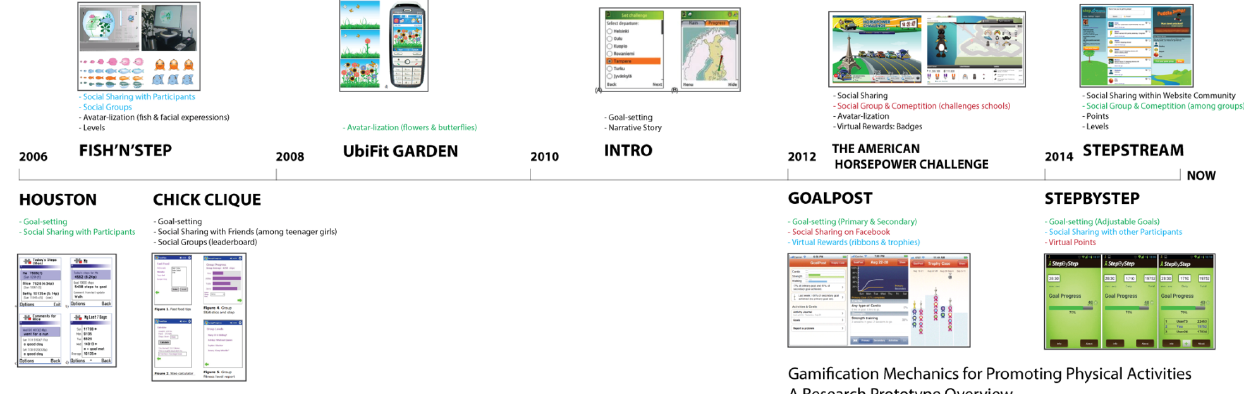
Figure 1 . An Overview of the Prototypes Mentioned in Related